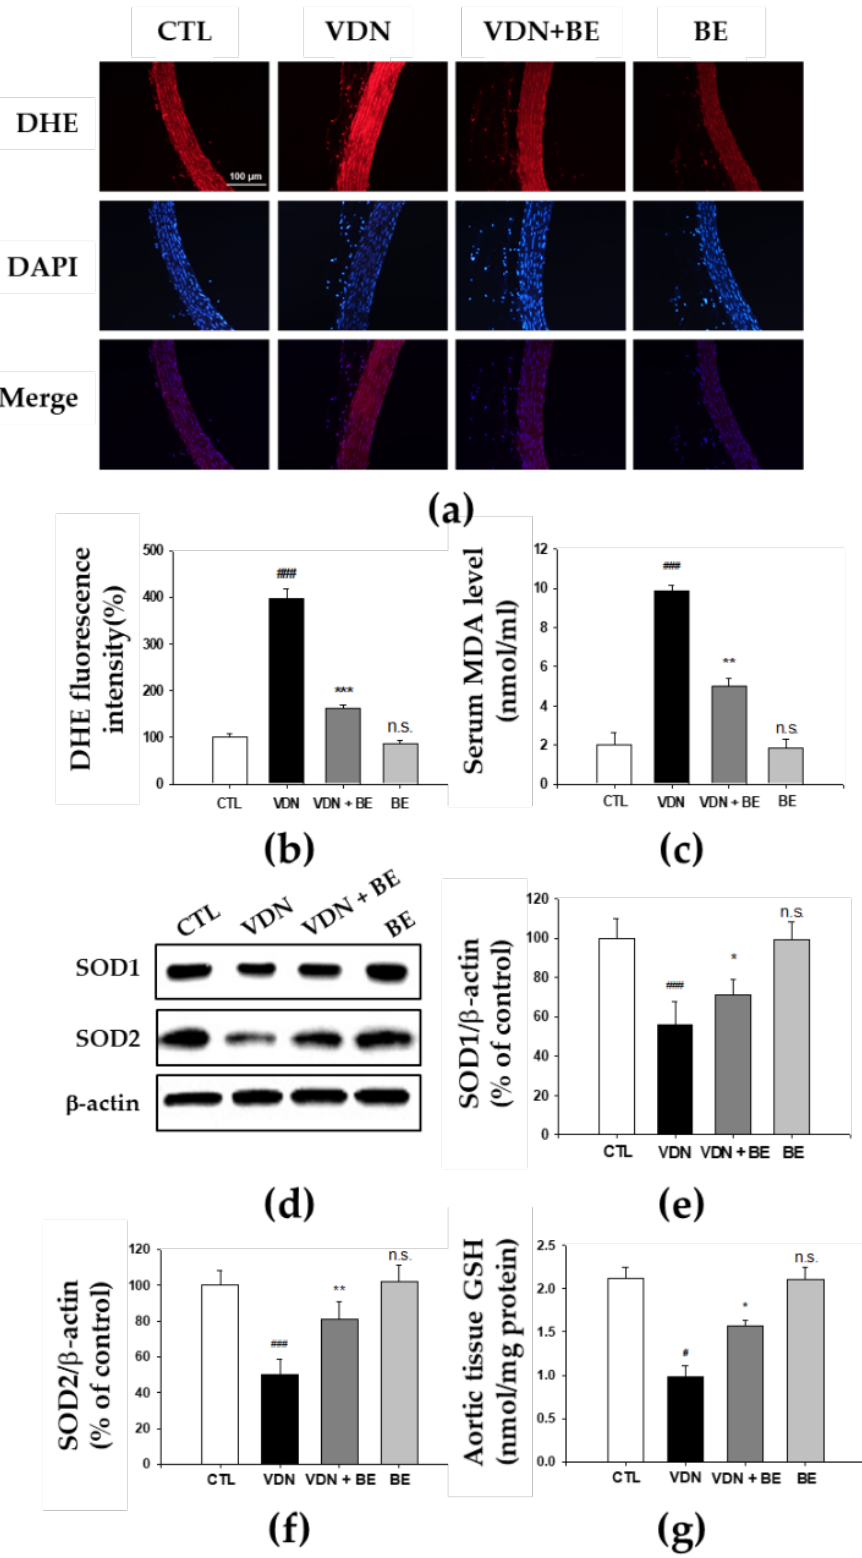
Figure 8. Effects of baicalein on VDN-induced oxidative stress markers in SD rats. ( a ) DHE staining to detect anion superoxide generation (200 × magnification) through confocal microscopic observation of nuclear thoracic aorta wall. Counterstaining of nuclei with DAPI in blue was merged into all images. ( b ) Quantified DHE fluorescence intensity relative to number of nuclei. ( c ) Level of MDA